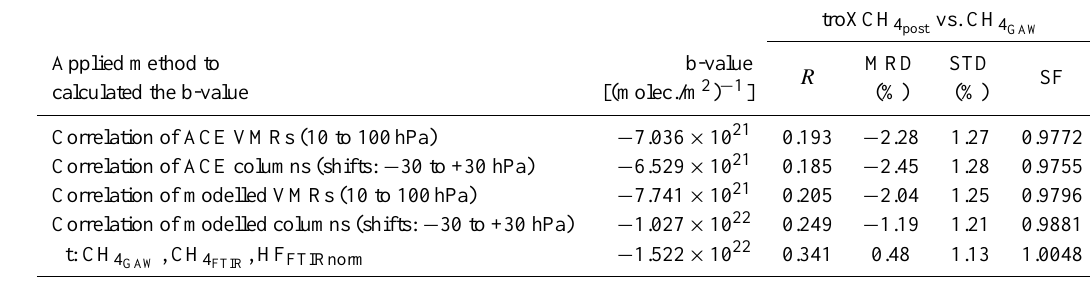
Table A2. Same as Table A1 but for normalised HF time series.